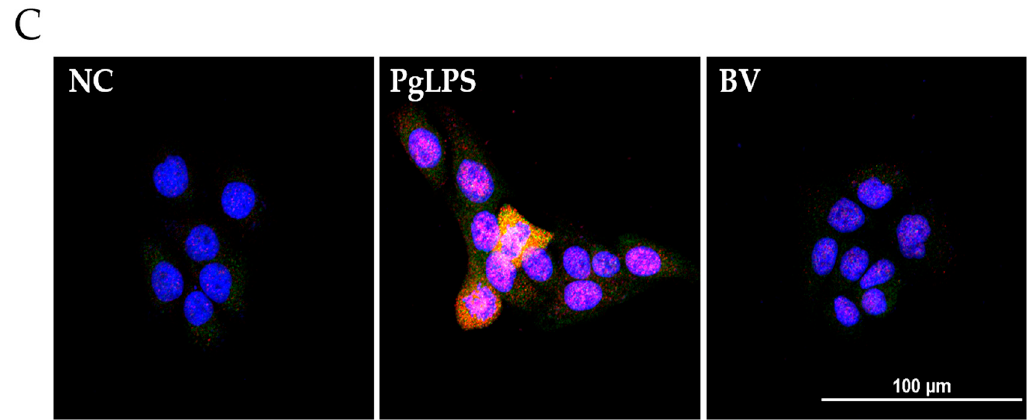
Figure 4. BV reduces the DNA binding activity of NF- κ B and AP-1 in PgLPS treated HaCaT cells. EMSA results showed that BV treatment suppresses the binding activity of NF- κ B ( A ); and AP-1 ( B ) in PgLPS-induced HaCaT cells. Results are representative of three independent experiments. +: treated; − : untreated; ( C ) BV inhibits the expression of TNF- α and NF- κ B in PgLPS-treated HaCaT cells. Representative immunofluorescence images show that 100 ng/mL of BV suppressed TNF- α (labeled with Alexa Fluor 488, green ) and NF- κ B (labeled with Alexa Fluor 555, red ). The nuclei were labeled with Hoechst 33342 ( blue ). NC: normal control; PgLPS: 0.1 μ g/mL of P. gingivalis LPS; BV: 0.1 μ g/mL of P. gingivalis LPS + 100 ng/mL of BV.